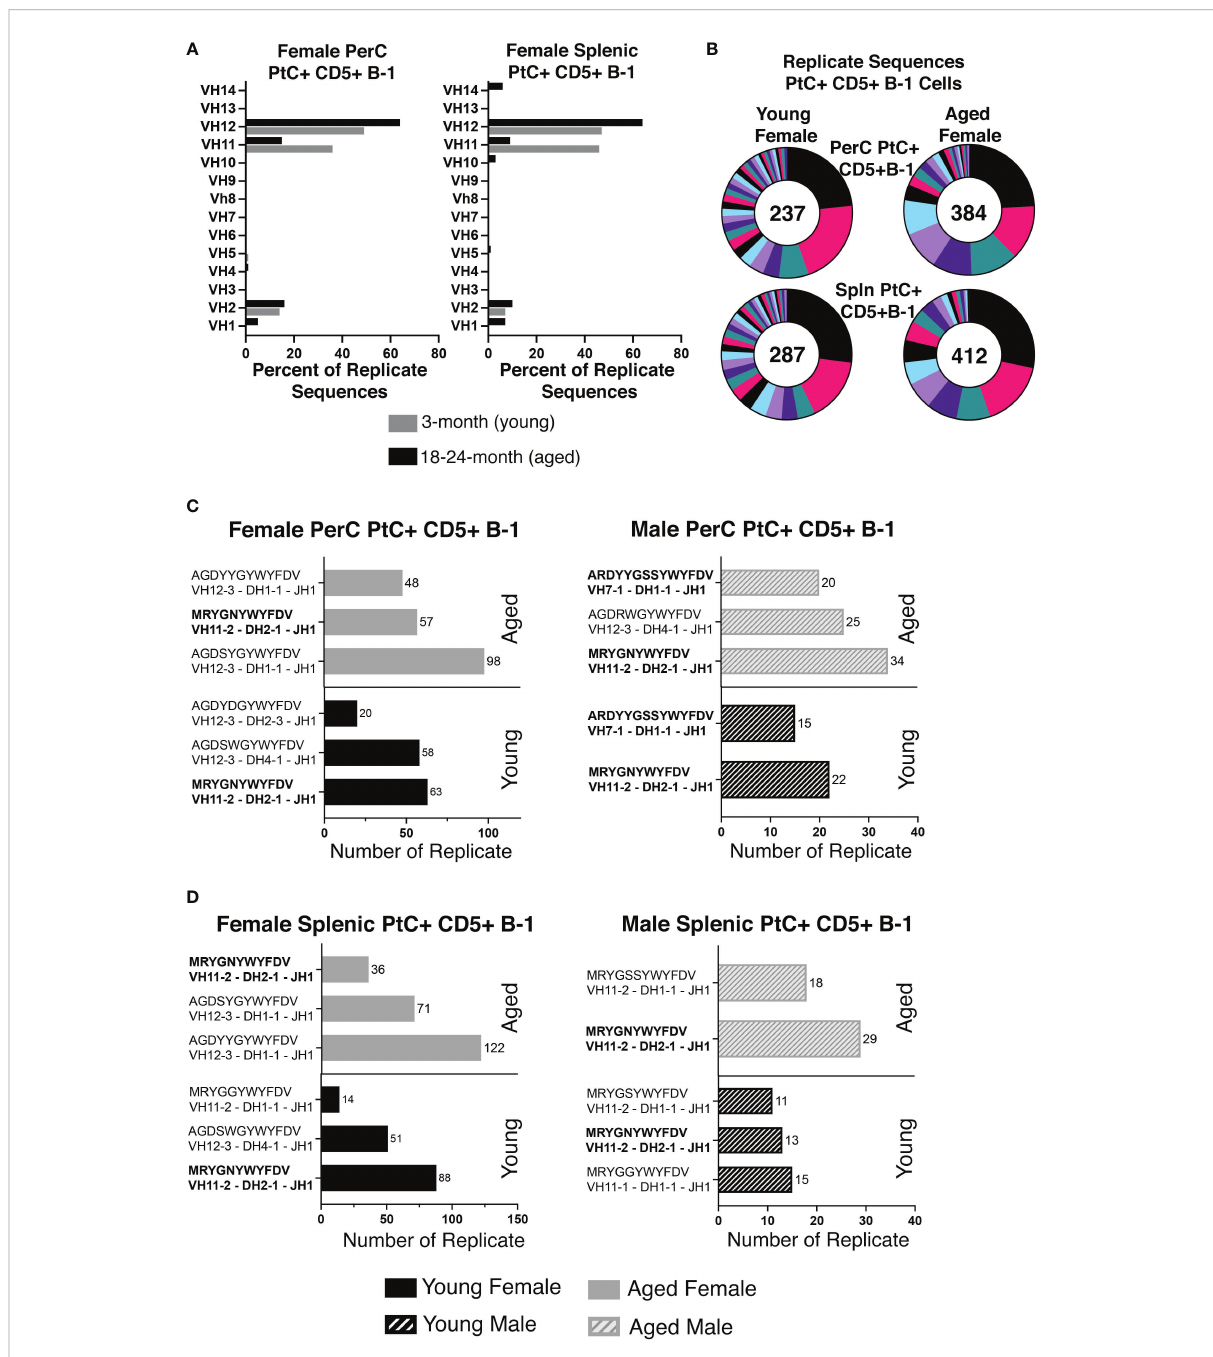
FIGURE 3 Signi fi cant differences in female versus male peritoneal and splenic PtC+CD5+ B-1 cell CDR-H3 use. PtC+CD5+ B-1 cells were single-cell sorted from the peritoneal cavity or spleen of young and aged female BALB/c-ByJ mice (as presented in Figure 2). (A) The percent of VH gene segment usage within the replicate sequences. (B) Distribution of replicate CDR-H3 sequences in the young and aged (number in the middle represents the number of replicates within the population). Each color represents a unique CDR-H3 amino acid sequence. (C, D) For direct comparison of females and males, previously published (24) CDR-H3 analysis of young and aged malePtC+CD5+ B-1 cells is included. (C) Comparison of the most frequently utilized CDR-H3 sequences of peritoneal PtC+CD5+ B-1 cells from young and aged male and female mice. (D) Comparison of the most frequently utilized CDR-H3 sequences of splenic PtC+CD5+ B-1 cells from young and aged male and female mice. Results are based on 4 independent experiments with sequences combined from each independent experiment (n=11 for 3-month-old mice, n=15 for 23-26-month-old female mice). Statistics used: 2x2 chi-square